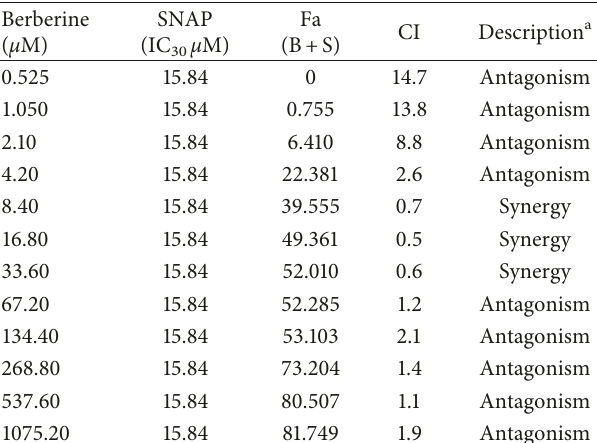
Table 3: Combination index determination for the combined effect of berberine and NO donor (SNAP).